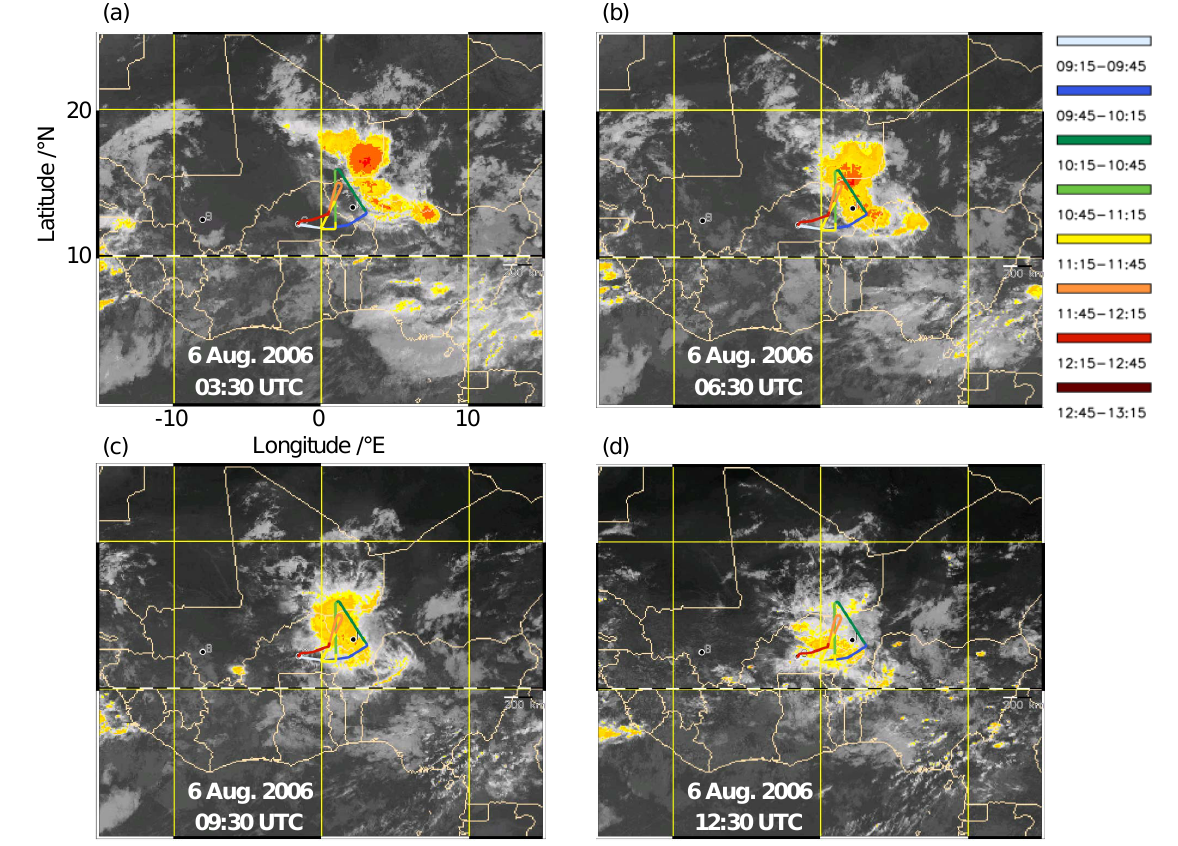
Fig. 1. Meteosat Second Generation (MSG) brightness temperatures over West Africa on 6 August 2006 for 03:30 (a) , 06:30 (b) , 09:30 (c) and 12:30UTC (d) (red 195K, orange 210K, yellow 225K). Superimposed is the Falcon flight track from Ouagadougou in Burkina Faso (colour-coded according to UTC time). The position of the MSC during take-off is indicated in (c) and the position during landing in (d) . Capital cities of Mali and Niger are indicated with black dots (B = Bamako to the west, N = Niamey to the east).